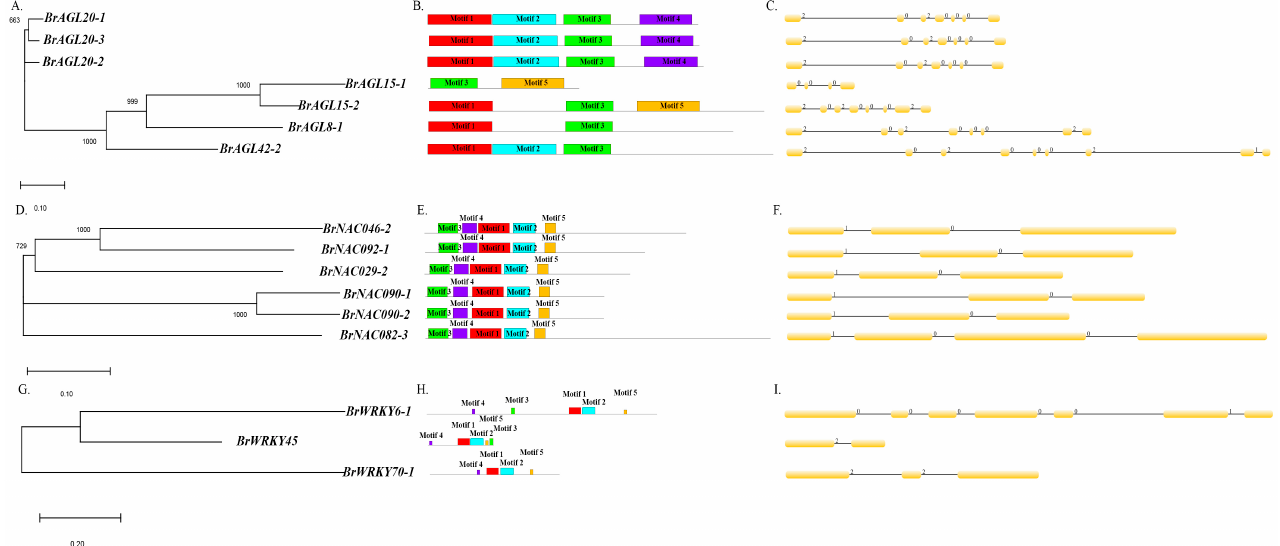
Figure 8. Structural comparison of differentially expressed MADS, NAC, and WRKY transcription factors. ( A , D , G ) Un- rooted neighbor-joining phylogenetic trees of AGAMOUS-LIKE, NAC, and WRKY transcription factors constructed using default parameters in MEGA X. As indicated by scale bars below each tree, branch lengths are proportional to the number of amino acid substitutions per 100 residues, thus reflecting the level of divergence among sequences. Numbers at nodes are bootstrap support values. ( B , E , H ) Distribution of introns and exons based on the GSDS web tool. The line below each set of introns and exons reflects the gene length. ( C , F , I ) Conserved motifs predicted using the MEME web tool.